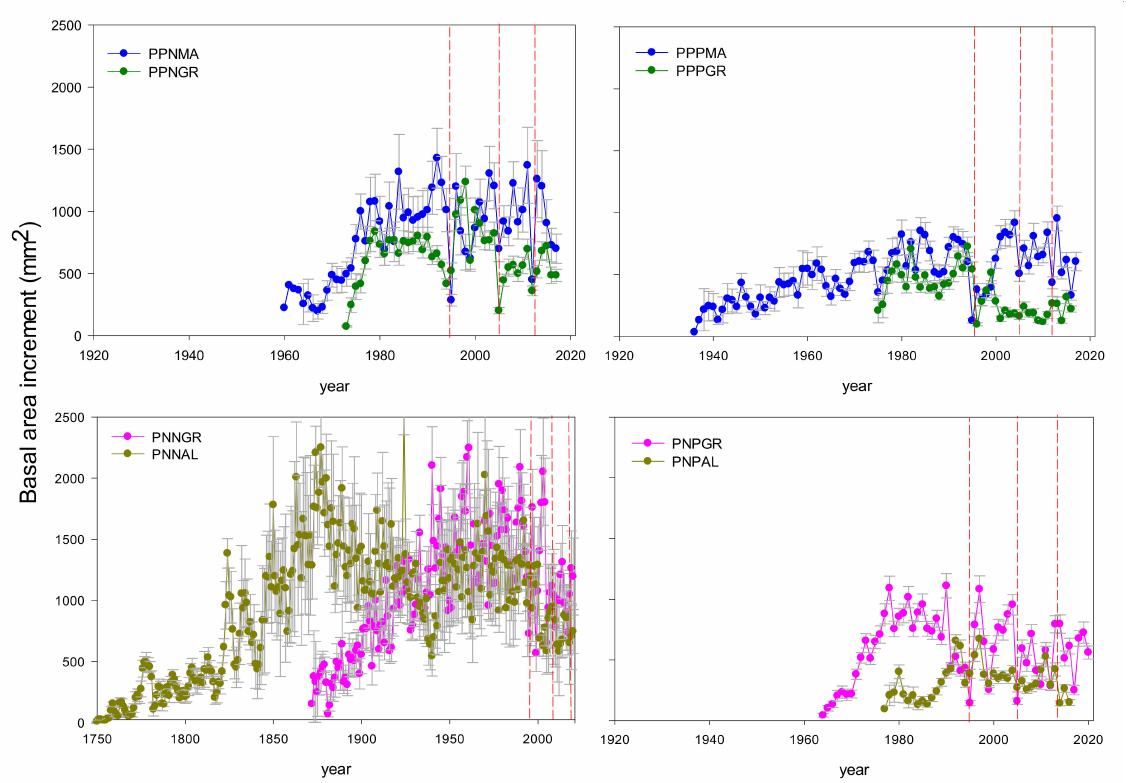
Figure 1. Mean series of basal area increment (BAI) of natural vs. planted P. pinaster stands ( above ) and P. nigra stands ( below ) along an aridity gradient in south-eastern Spain. Sampled sites correspond to P. pinaster (PP) and P. nigra (PN) natural (PPN and PNN) and planted (PNP and PPP) stands. Gray bars correspond to standard errors and vertical red dashed lines show dry years (1995, 2005 and 2012). Sites’ abbreviations: PPNMA, P. pinaster natural (M á laga); PPPMA, P. pinaster planted (M á laga); PPNGR, P. pinaster natural (Granada); PPPGR, P. pinaster planted (Granada); PNNGR, P. nigra natural (Granada); PNPGR, P. nigra planted (Granada); PNNAL, P. nigra natural (Almer í a) and PNPAL, P. nigra planted (Almer í